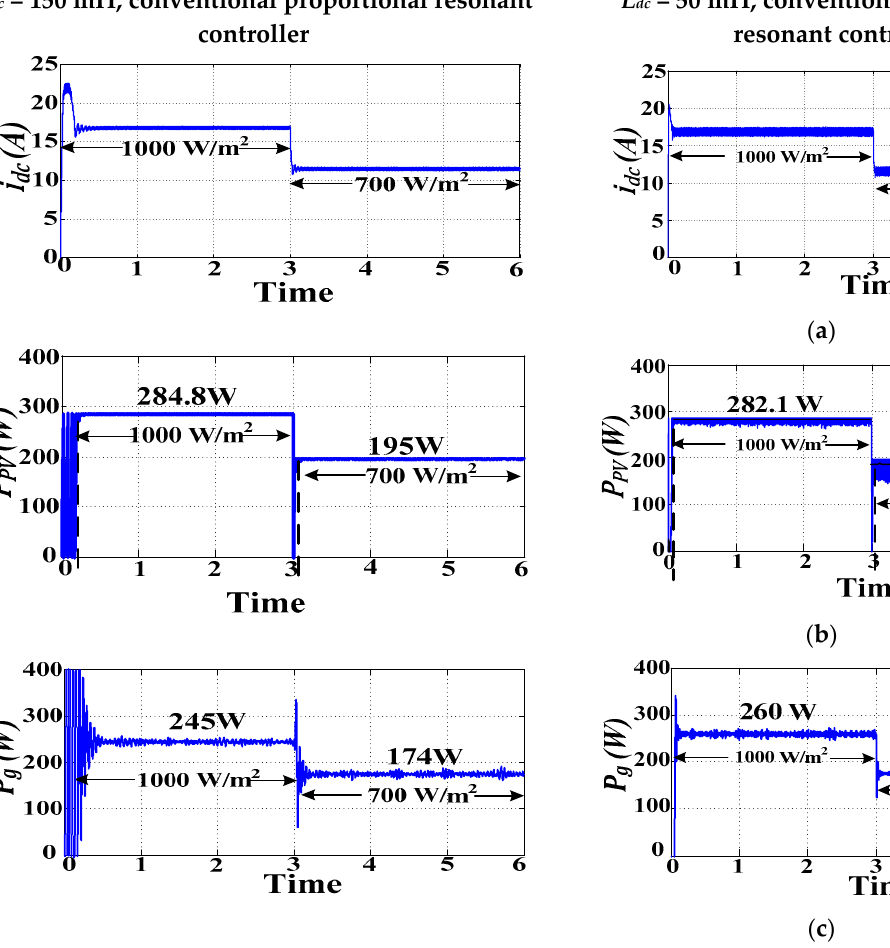
Figure 3. System performance comparison between conventional proportional resonant controller (CPRC) and proposed cascaded harmonic controller (PCHC) under irradiance variation: ( a ) DC-link current, ( b ) PV power, and ( c ) average grid power.